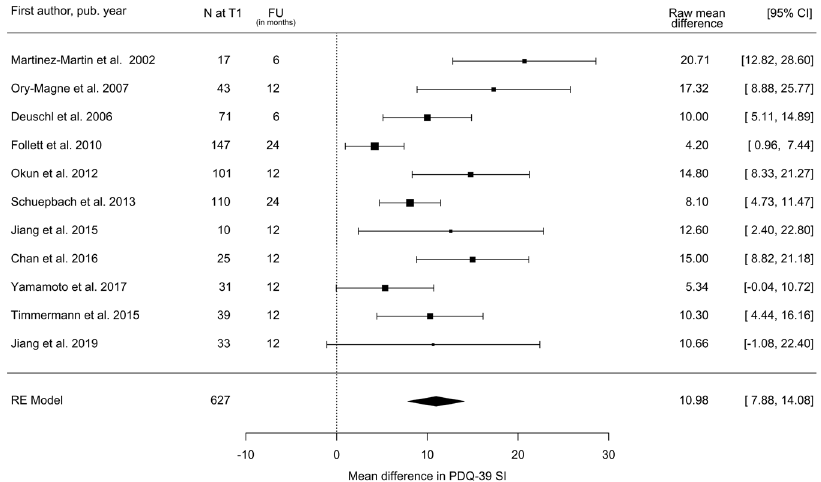
Fig. 7 Change in total PDQ-39 summary index (SI) score following STN-DBS. Postoperative vs. preoperative state: PDQ-39 (SI) Mean Difference. N = number of subjects at follow-up; FU = follow-up time; CI = con fi dence interval; RE Model = random-effects